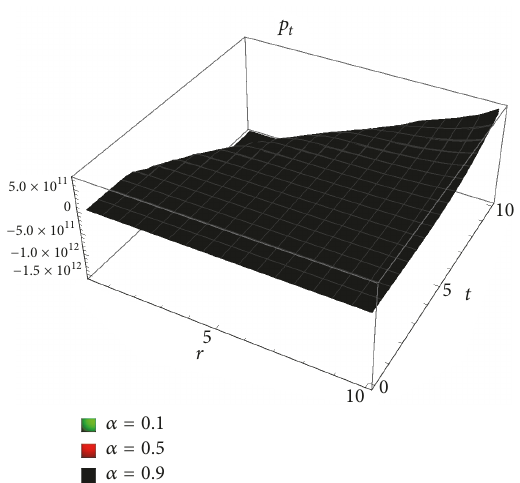
Figure 7: Density behavior along 𝑟 and 𝑡 for 𝑟 0 = 0.5 and the different values of 𝛼 .